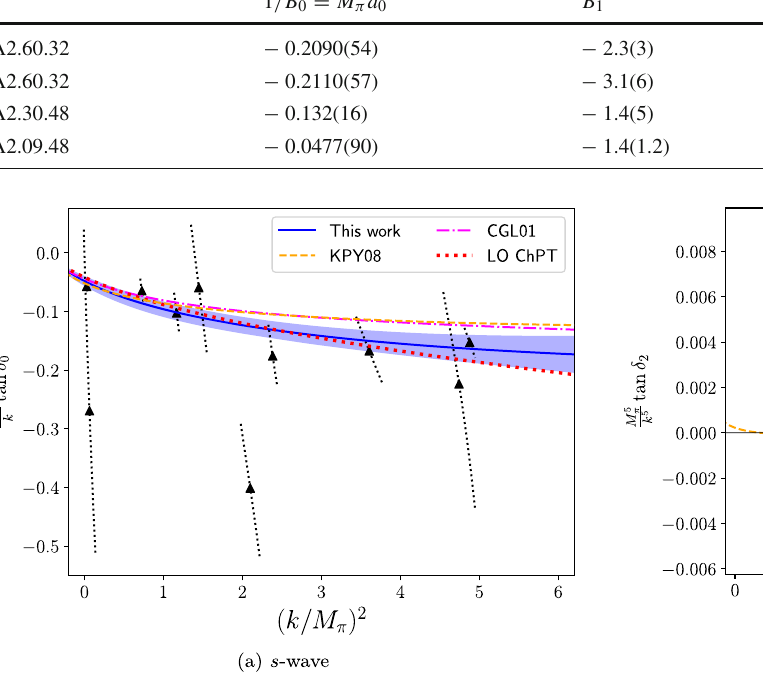
the Adler-zero, whereas for d -wave we fit to a constant in the region for which we have data